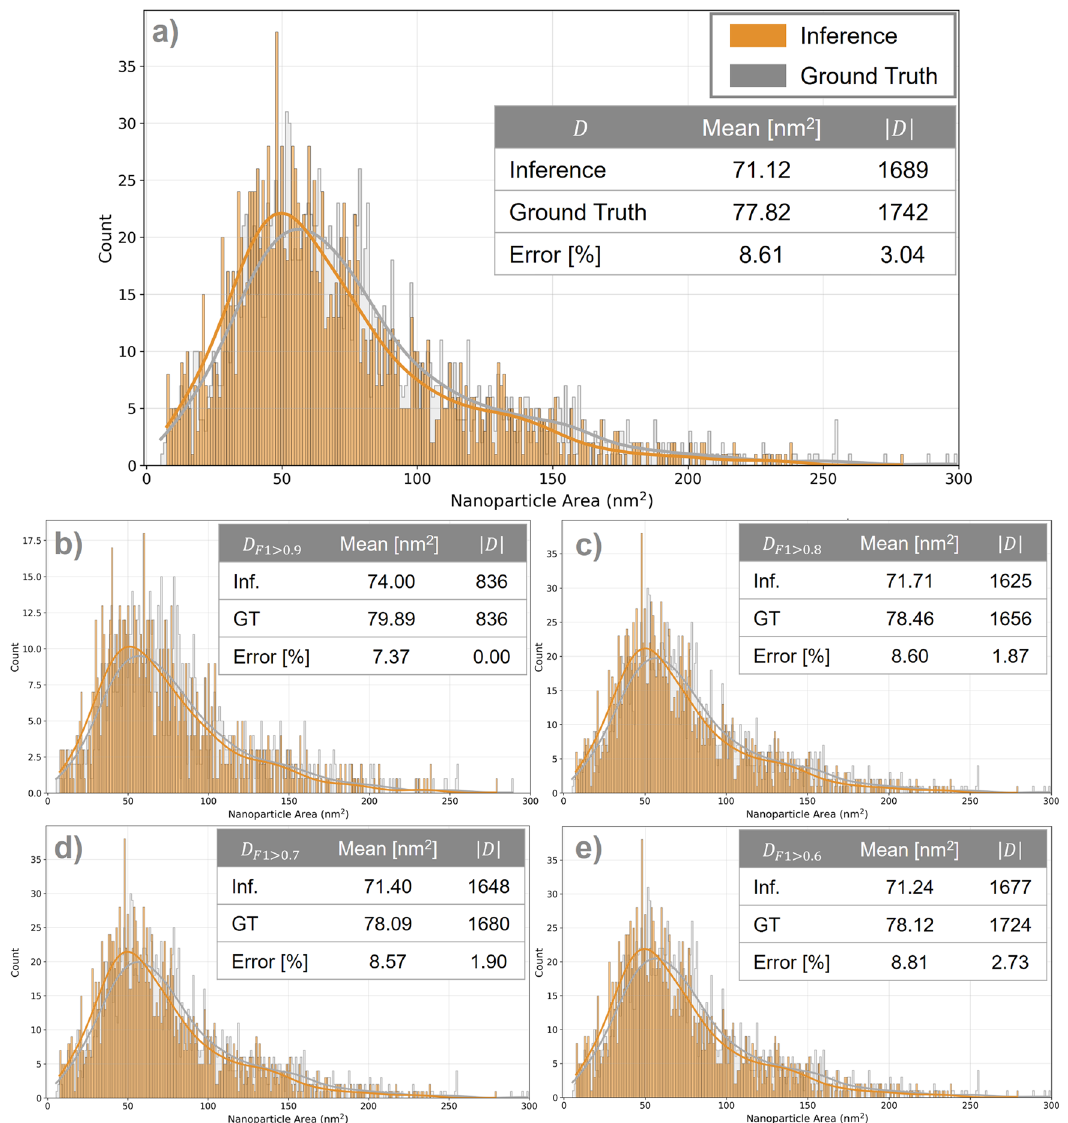
Fig. 5 Histograms (1 nm 2 ∙ bin − 1 ) and KDE-plots of calculated nanoparticle areas (nm 2 ) for the ground truth and inferred datasets for the Au/Ge system. KDE-plots were generated using a Gaussian Kernel and Scott ’ s rule 53 . Tables containing the calculated mean nanoparticle area (nm 2 ), nanoparticle counts in the dataset (| D |) and calculated errors with respect to the ground truth are also shown. A minimum nanoparticle size of 50 pixels was assumed for all images. a The full dataset, b Images with an F1-Score of >0.9, c Images with an F1-Score of >0.8, d Images with an F1-Score of >0.7 and e Images with an F1-Score of plots when compared to the ground truth (Supp. Table 4). Both, the x y max prediction as well as the FWHM settle at x y max = 13.23, FWHM = 32.69 and x y max = 10.45, FWHM = 24.08 for the inference and ground truth respectively, once the sub-dataset F1-score >0.6 is included. Although the estimates in the KDE plot from the inference are higher, they remain close to the ground truth, indicating a high measurement performance for those sub- datasets, especially when considering the full shapes of both KDE-plots.